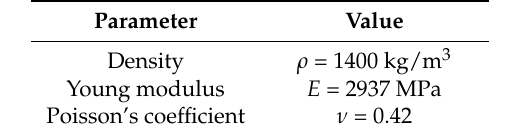
Figure 1. Dispersion curves of ultrasonic waves in a PVC film of 0.135 mm thickness: v ph —phase velocity of A 0 mode, v gr —group velocity of the A 0 mode, v air —velocity in air. Table 1. PVC material parameters.